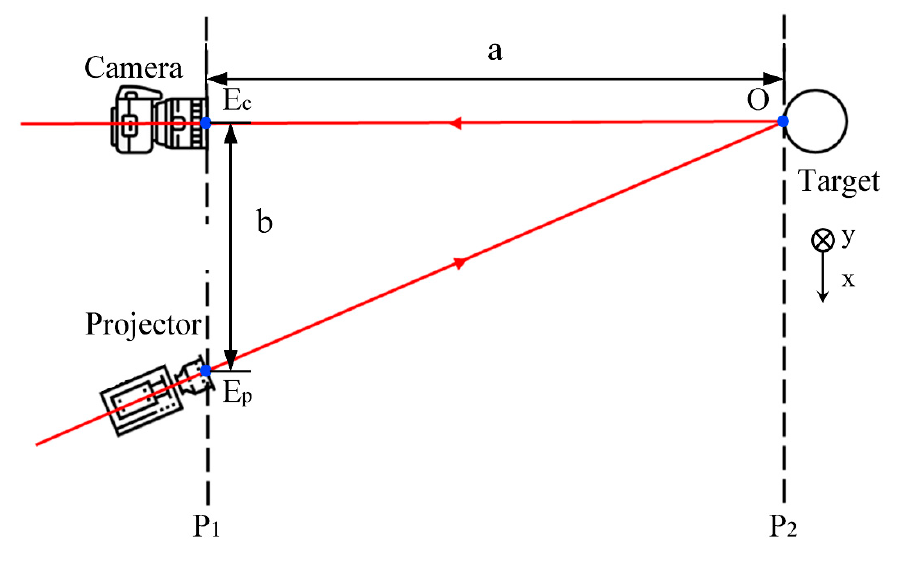
Figure 1. Crossed-optical-axes geometry.